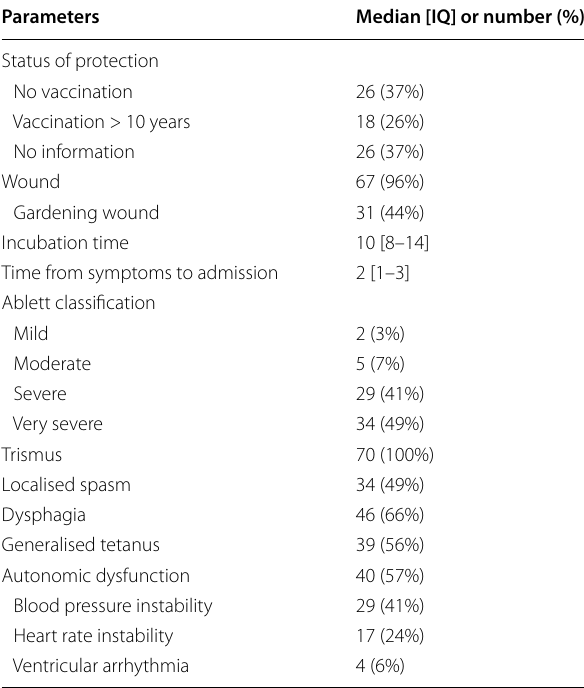
Table 2 Characteristics of tetanus and specific manage-